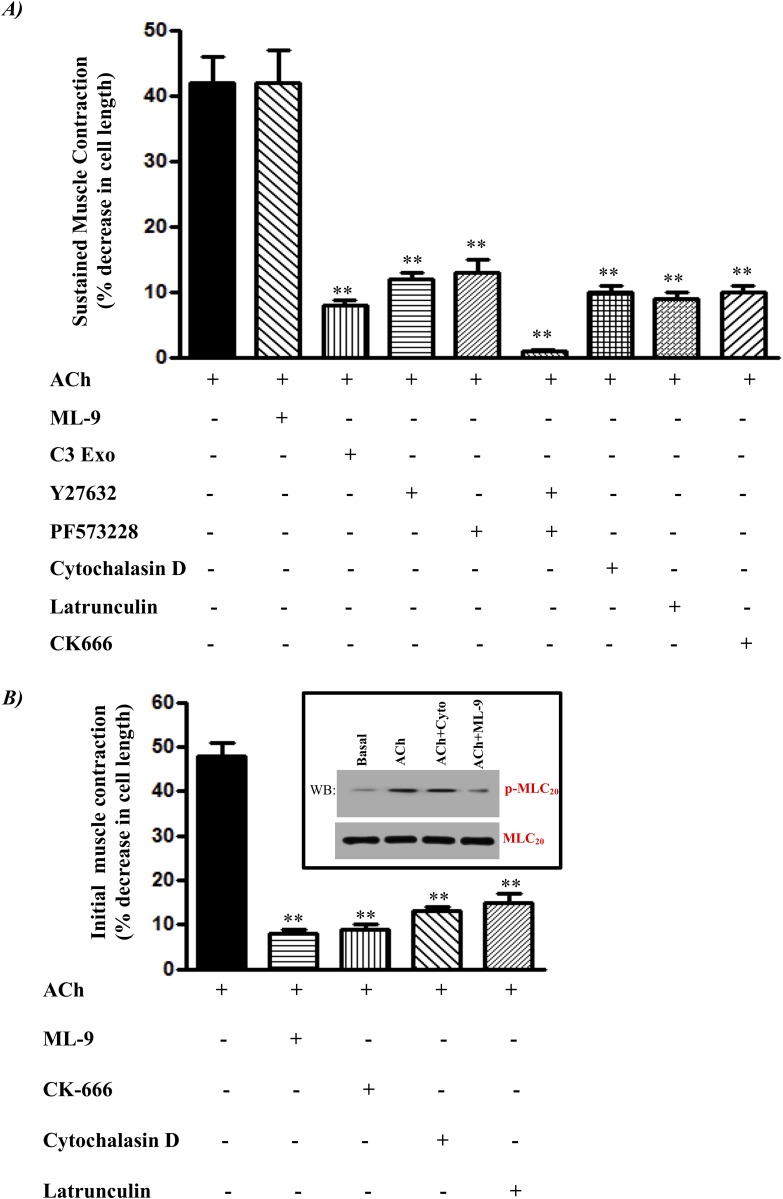
Inhibition of sustained and initial actin polymerization prevents ACh-induced sustained and initial smooth muscle contraction in muscle cells.Muscle contraction was measured by scanning micrometry. A: Pre-treatment of dispersed smooth muscle cells with the MLCK inhibitor ML-9 (10 μM, 10 min), RhoA inhibitor Clostridium botulinum C3 exoenzyme (2μg/ml, 1 h), Rho kinase inhibitor Y27632 (10 μM, 10 min), FAK inhibitor PF573228 (10 μM, 1 h) or Arp2/3 inhibitor CK-666 (200 μM, 1h), actin polymerization inhibitors (cytochalasin D, 10 μM; latrunculin, 1 μM, 1 h) was followed by 1 μM ACh for 10 min. B: Pre-treatment of dispersed smooth muscle cells with MLCK inhibitor, ML-9 (10 μM, 10 min), or Arp2/3 complex inhibitor, CK-666 (200 μM, 1h), and actin polymerization inhibitors (cytochalasin D, 10 μM; latrunculin, 1 μM, 1h) followed by 1 μM ACh for 1 min. The results are expressed as percentage decrease in cell length. Insert: MLC20 phosphorylation was measured by western blot using phospho specific antibody. Pre-treatment of cultured smooth muscle cells with MLCK inhibitor, ML-9 (10 μM, 10 min) and actin polymerization inhibitor (cytochalasin D, 10 μM, 1h) followed by 1 μM ACh for 1 min. Values are means ± SE of three experiments. **P<0.001.